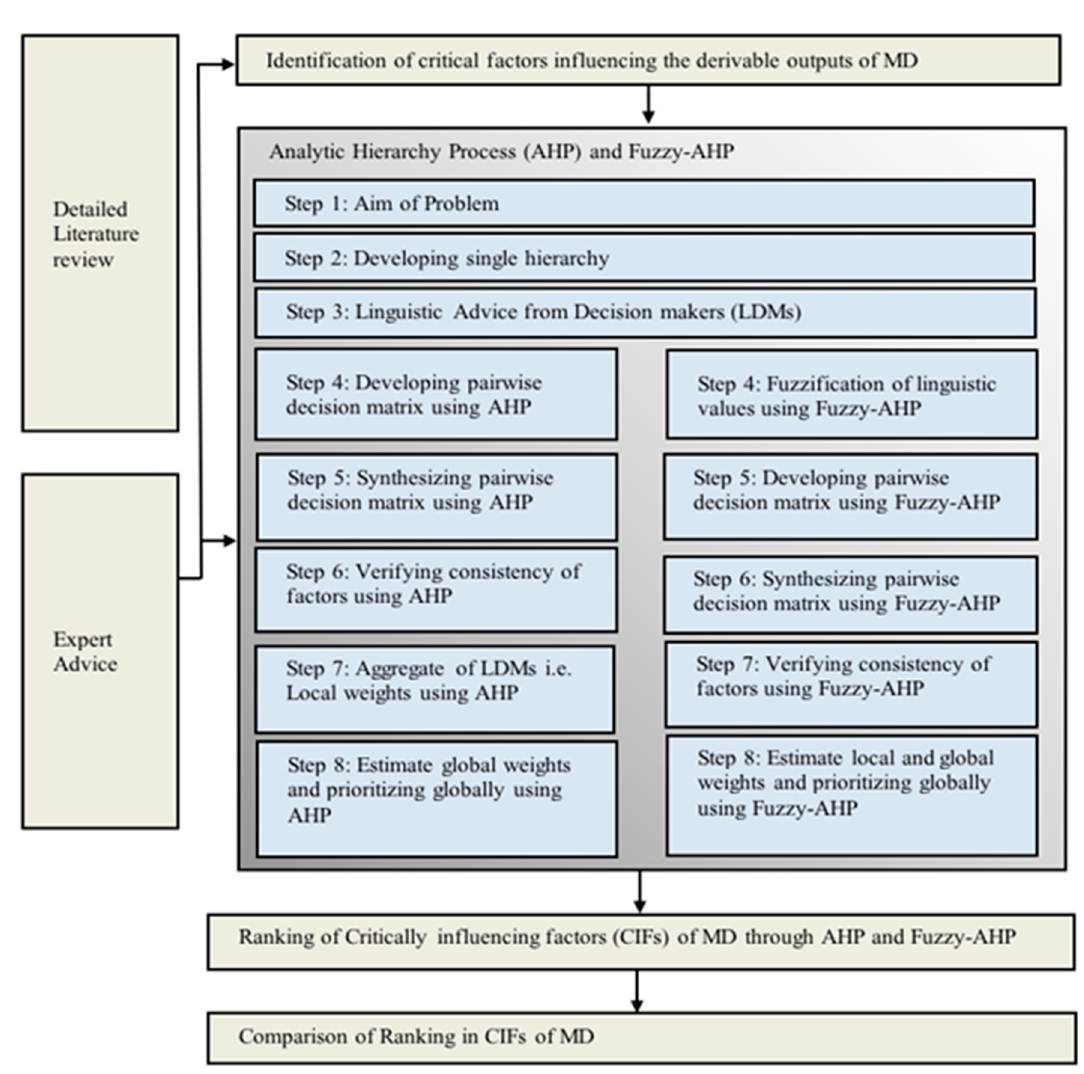
Figure 2. Framework of critical influencing factors of membrane distillation (MD) based on Fuzzy-Analytical Hierarch process (AHP)-multiple decision-maker (MDM). Table 1. Derivable output and critical influencing factor (CIF) of MD.